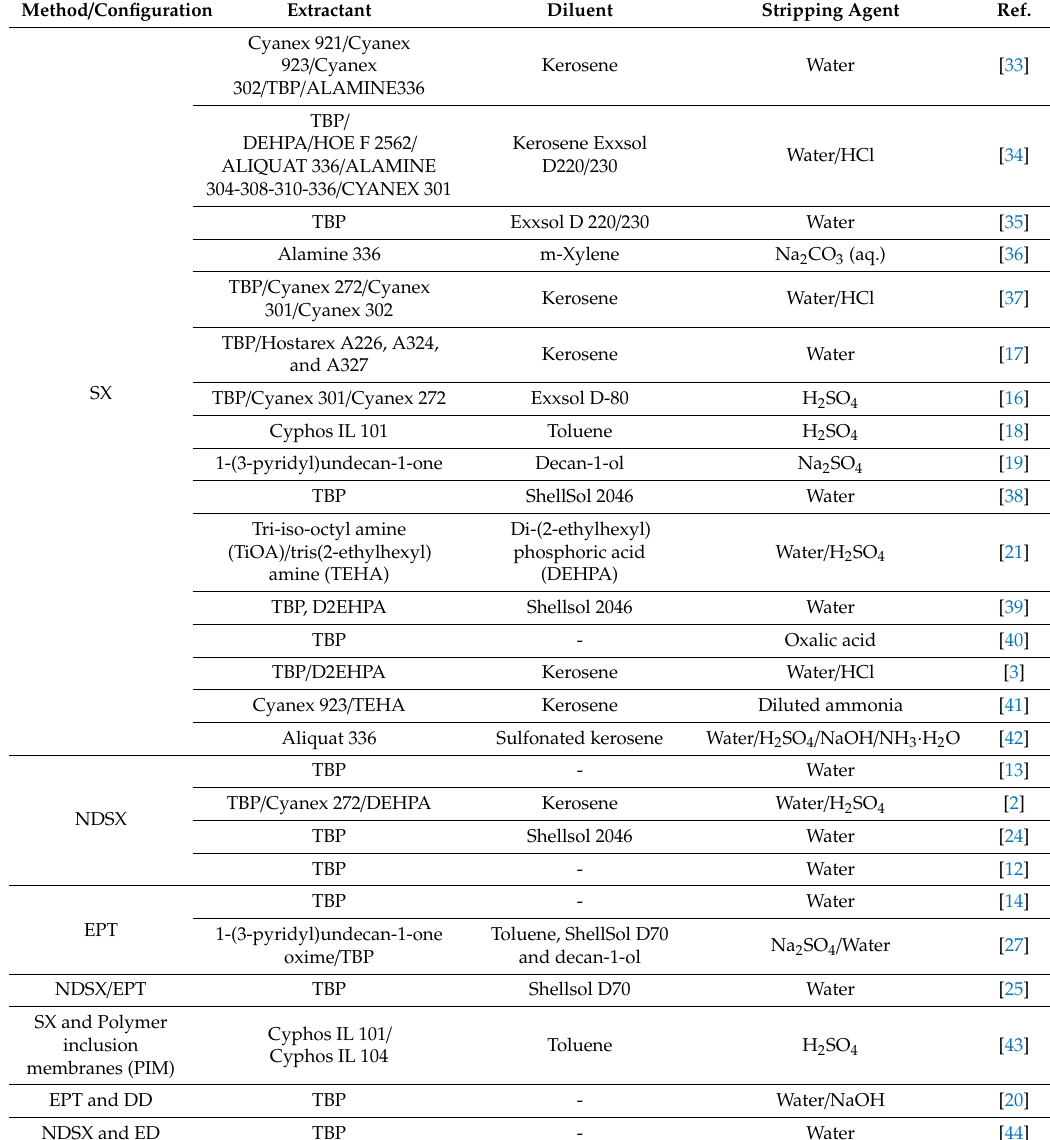
Table 2. Literature review of zinc recovery from spent pickling acids (SPAs) by solvent extraction (SX) and membrane-based solvent extraction